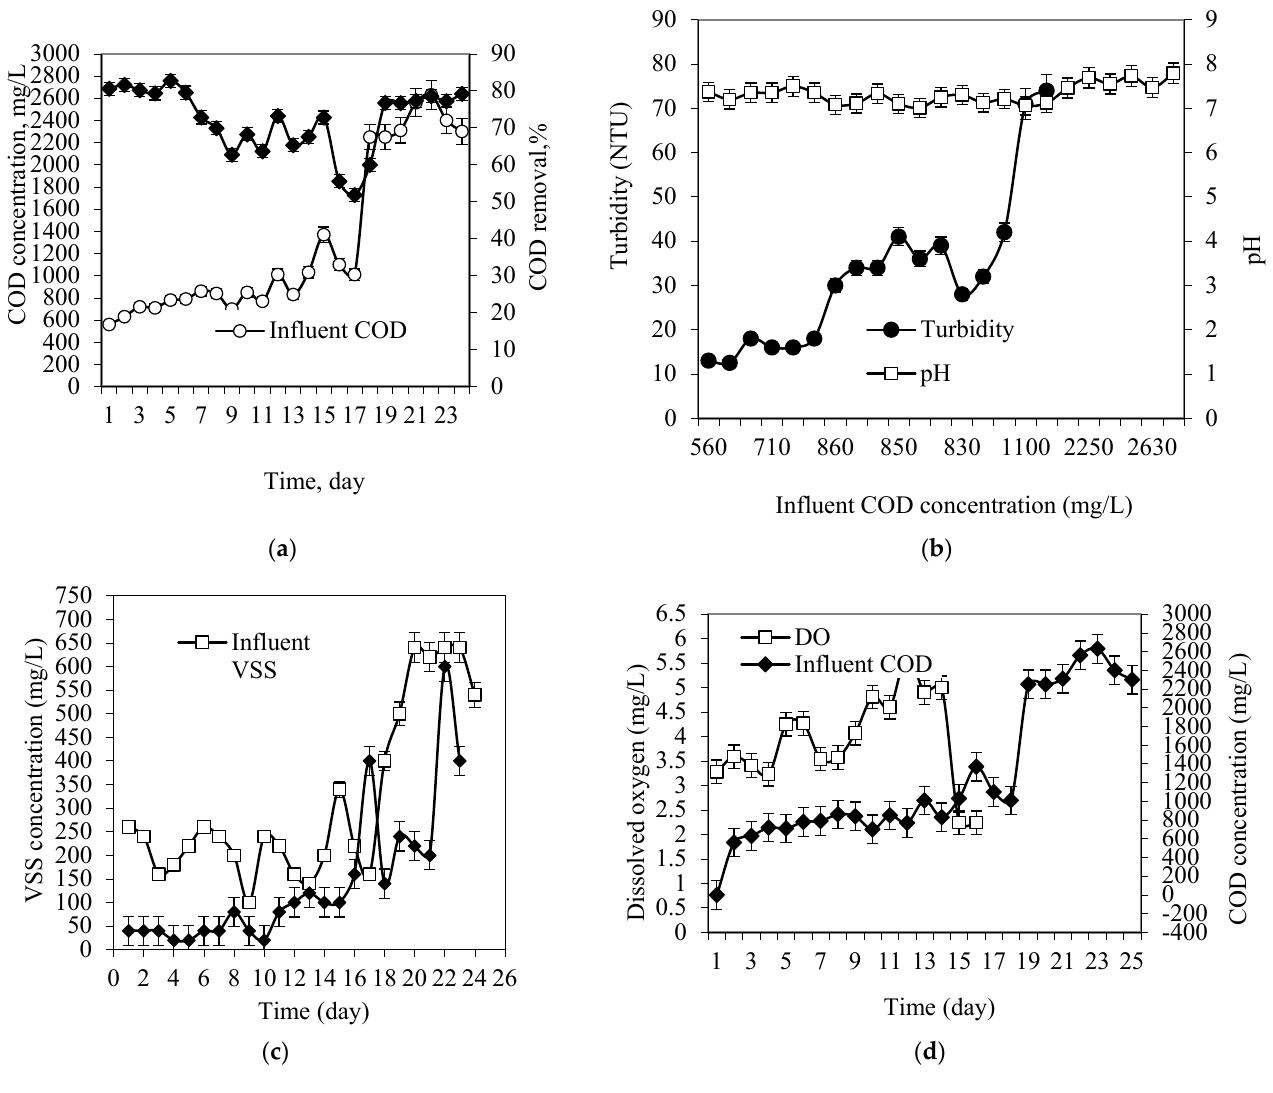
Figure 3. ( a ) COD removal efficiency; ( b ) effluent pH and turbidity variations; ( c ) influent and effluent VSS variations; ( d ) influent COD and DO levels during start-up period.